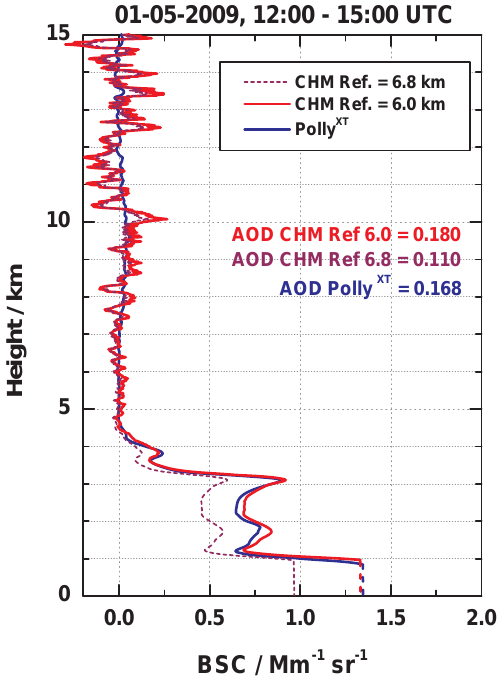
Fig. 2. Daytime particle backscatter coefficient profiles derived from the CHM ceilometer data from DWD in Holzhausen (in red) and lidar data (in blue). The mean AOD measurement from the AERONET sun photometer (level 2.0 data) for this time period interpolated to 1064nm is 0.140. Different results for particle backscatter coefficient profiles are obtained from the ceilometer data when varying the reference height chosen in the retrieval. For instance choosing the reference height at 6.8km results in the parti- cle backscatter coefficient profile in dashed purple and a calculated AOD of the 0.110, which is too low. The reference value for the backscatter coefficient is 10 − 12 Mm − 1 sr − 1 in both